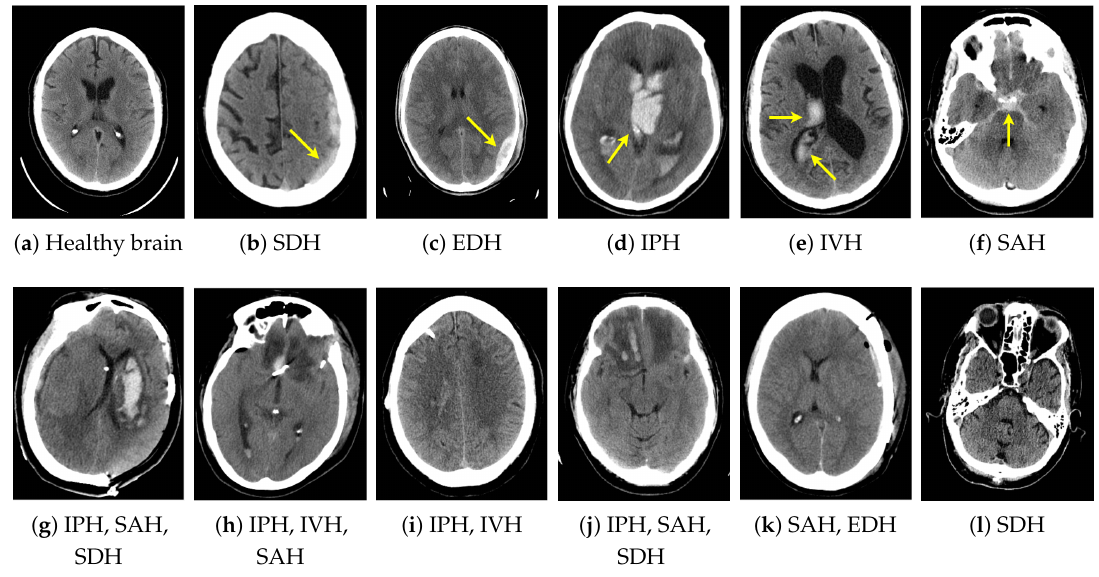
Figure 1. Sample non-contrast computed tomography (CT) slices with various intracranial hemorrhage (ICH) subtypes in the top row ( a – f ). Yellow arrows indicate the areas of hemorrhage. Complex cases are shown in the bottom row: combinations of multiple ICH subtypes simultaneously ( g – k ) or barely visible ICH symptoms ( l